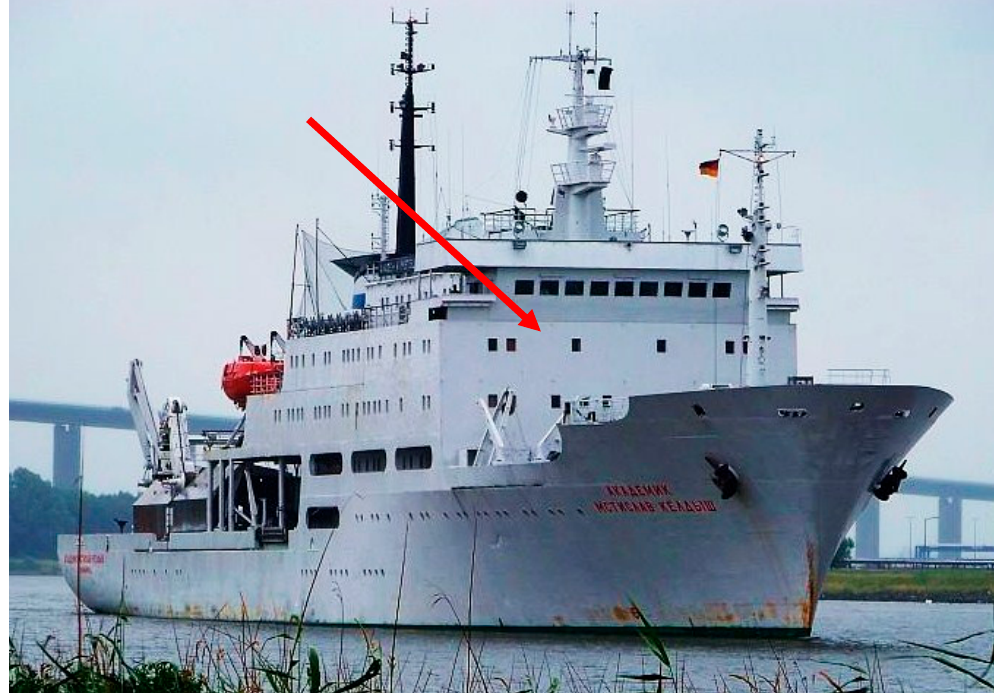
Figure 2. Location of the analysis system air inlet (indicated by red arrow) aboard the R/V Akademik Mstislav Keldysh. 18.5 m—measurement height above sea level.